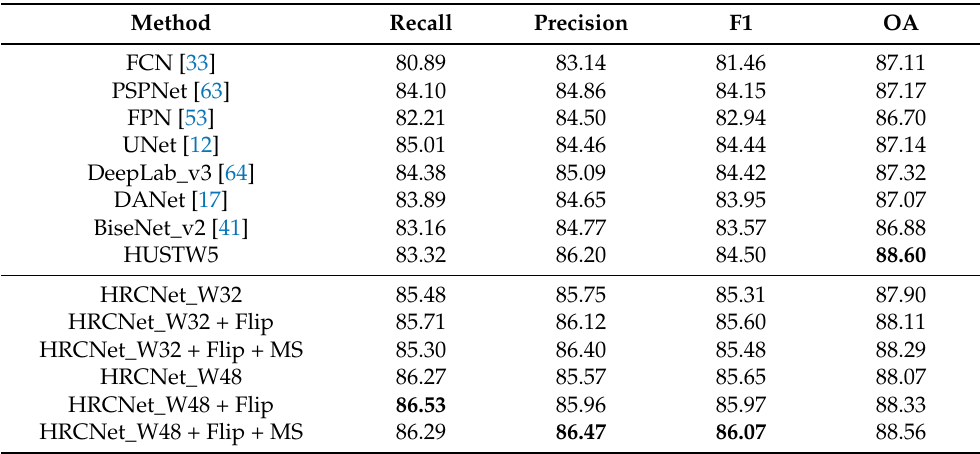
Table 7. Results (%) on the Vaihingen dataset with full reference.